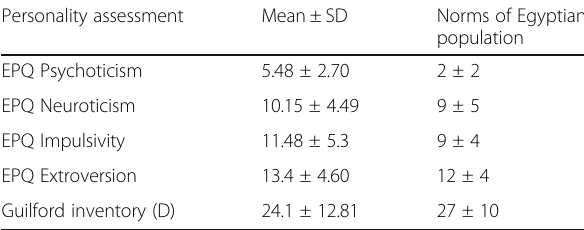
Table 2 Personality traits using the EPQ and D-scale of Guilford